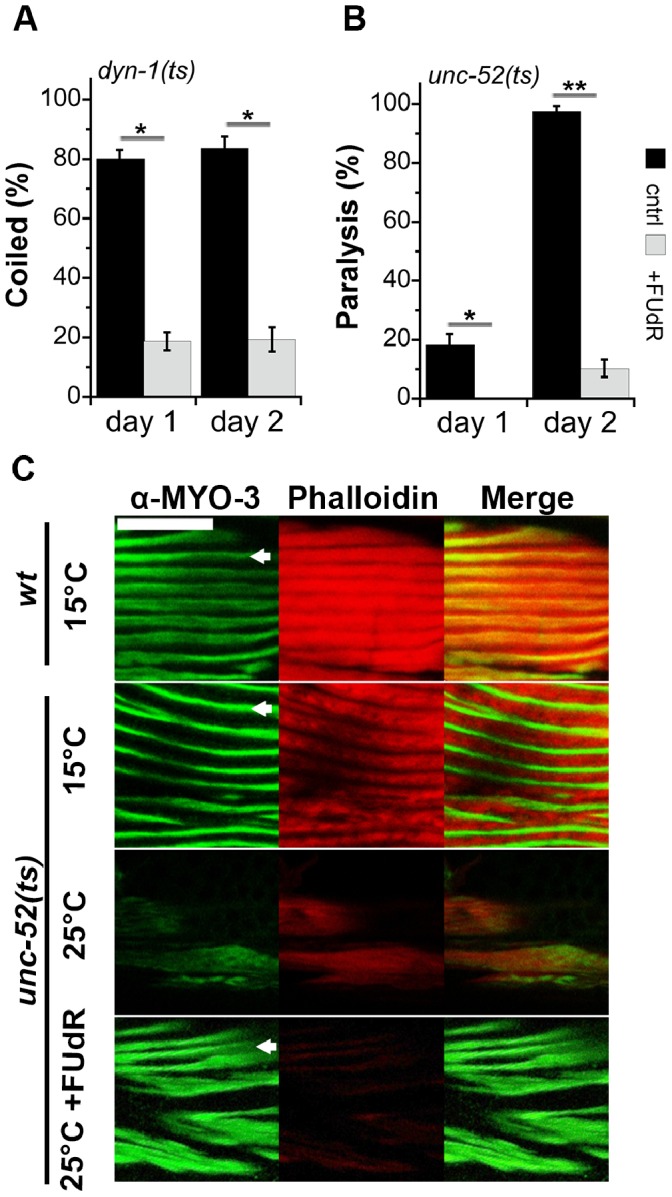
FUdR treatment improved proteostasis after the onset of reproduction.(A) Age-synchronized dyn-1(ky51) animals raised in the absence (black) or presence (gray) of FUdR were shifted to 28°C on the first or second days of adulthood and the percent of coiled animals was scored. Data represent means ± SEM of 4 independent experiments. P values compare age-matched treated and untreated animals. (*) P<0.05. (B) The motility of age-synchronized temperature-sensitive unc-52(e669su250) animals raised in the absence (black) or presence (gray) of FUdR was examined on the first and second days of adulthood and the percent of paralyzed animals was scored. Data represent means ± SEM of 5 independent experiments. P values compare age-matched treated and untreated animals. (*) P<0.05 and (**) P<0.01. (C) Confocal images of age-synchronized unc-52(e669su250) animals raised in the absence or presence of FUdR, and stained with anti-MYO-3 antibodies (green) and phalloidin (red). Arrows indicate myofilaments. Scale bar is 10 µm.